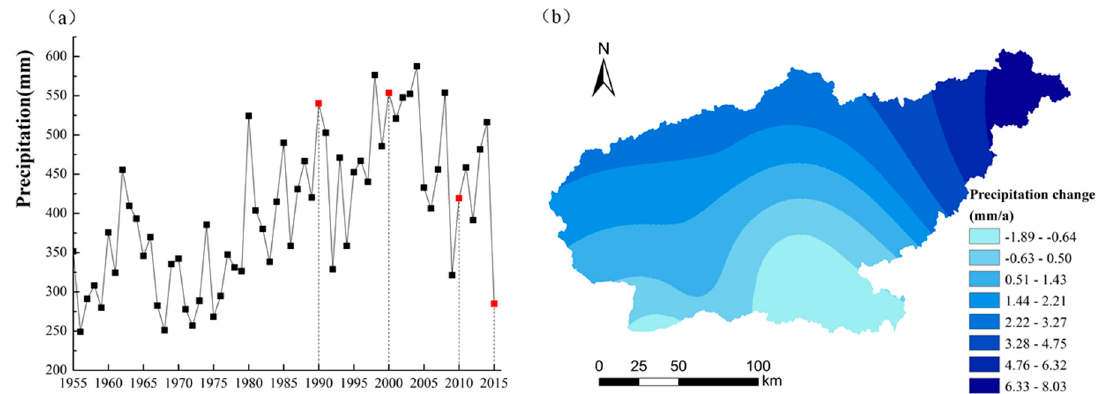
Figure 4. ( a ) Annual mean precipitation (the red plots indicate the year 1990, 2000, 2010, and 2015) and ( b ) spatial precipitation changing trend in the Lhasa River Basin over the past six decades.